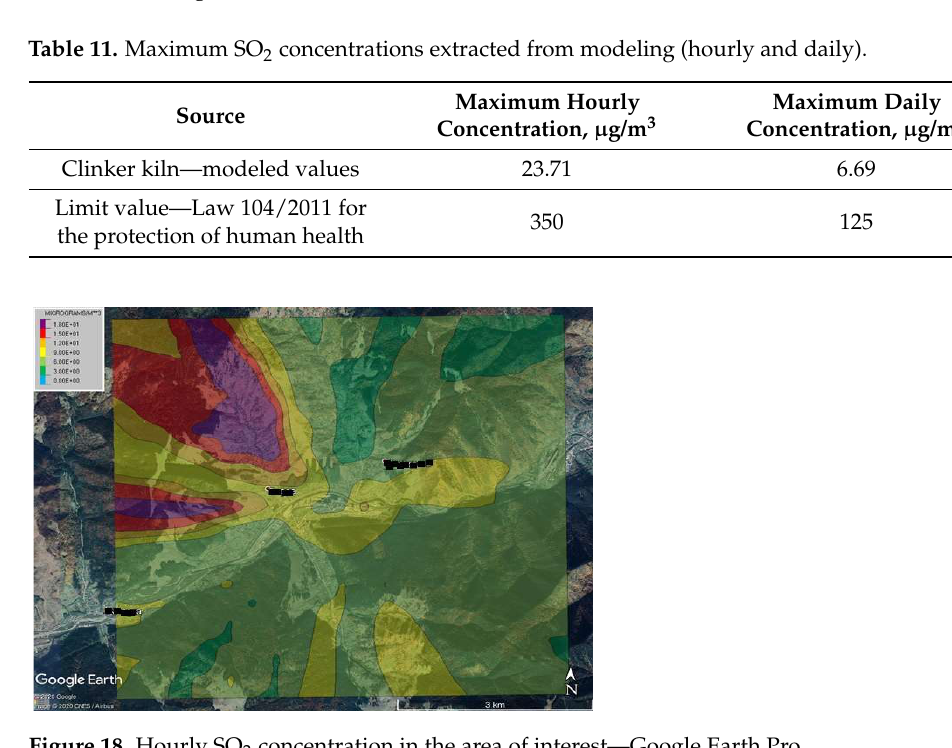
It is observed that the maximum value of the modeled CO concentration complies